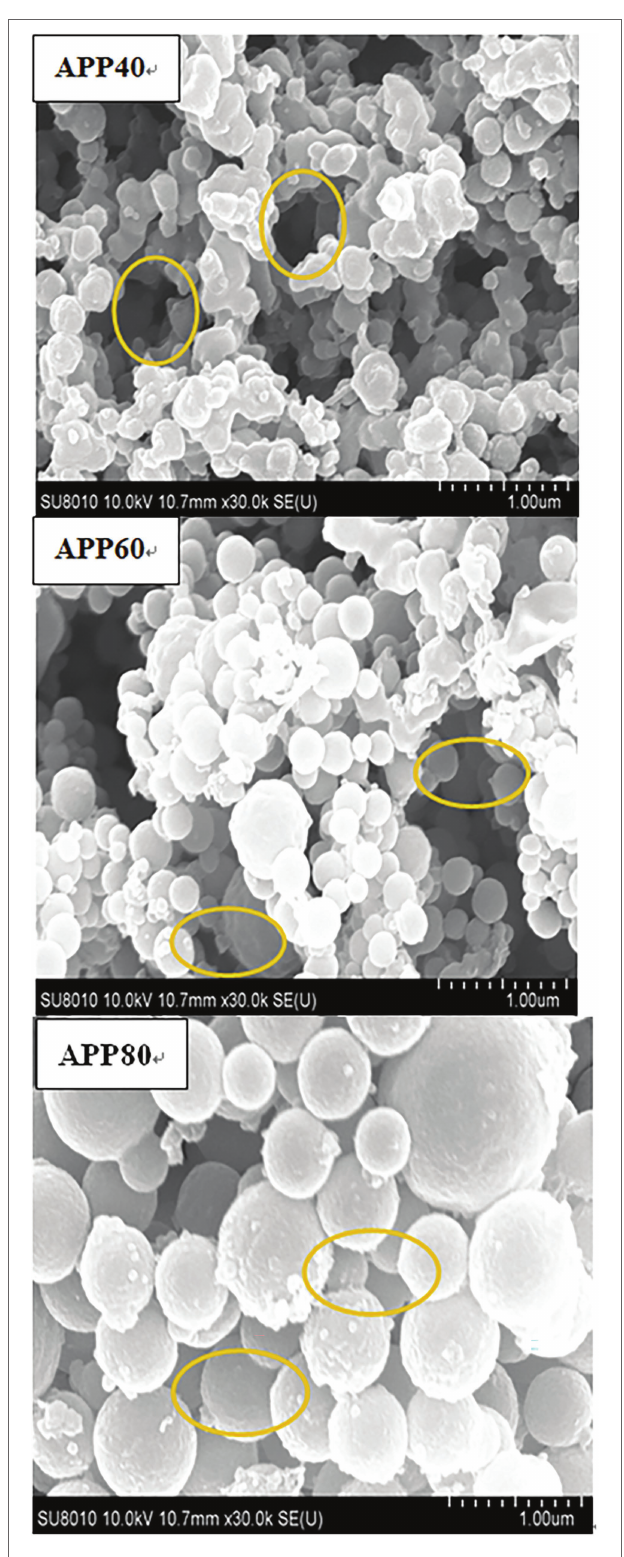
FIGURE 7 | Scanning electron micrograph of precipitated at the ethanol concentration of 40% (APP40), precipitated at the ethanol concentration of 60% (APP60), and precipitated at the ethanol concentration of 80% (APP80).